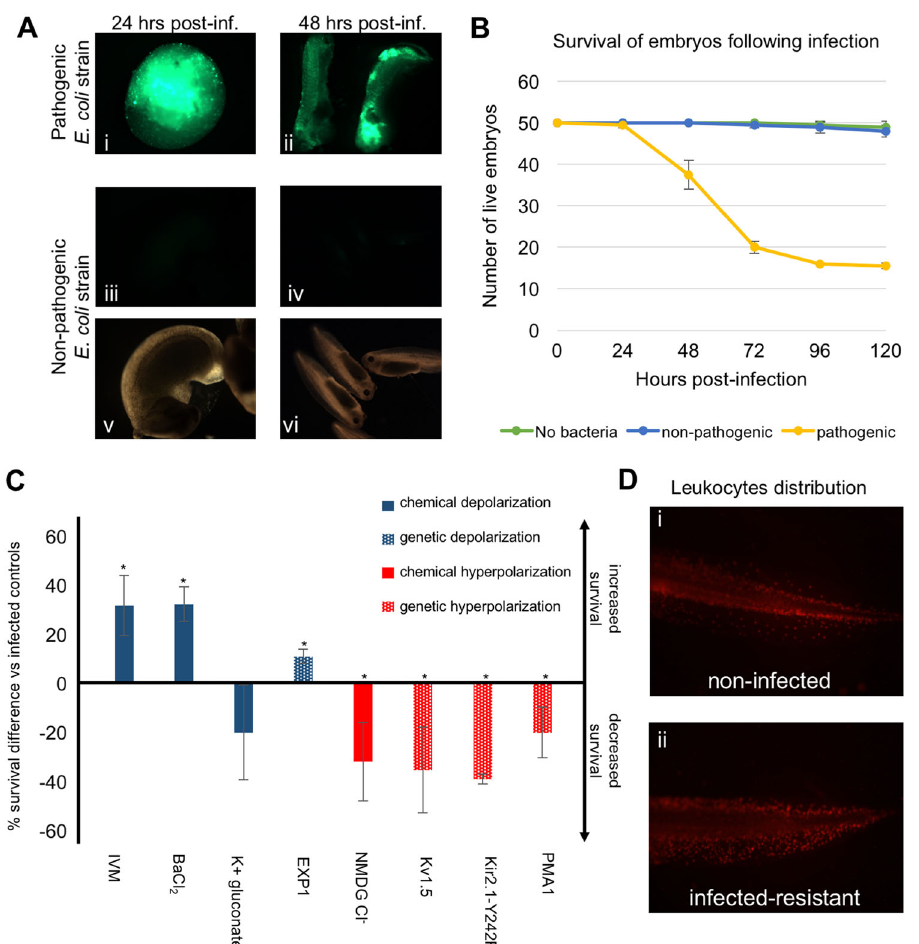
Fig. 1 Uropathogenic E. coli can produce systemic infection of gastrula-stage X. laevis embryos, whose V mem modulates immune response to infection. a Widely distributed uropathogenic E. coli -derived-GFP fl uorescence is detected under fl uorescence microscopy in embryos infected 24 h (panel i) or 48 h (panel ii) before the image was captured. In contrast, the non-pathogenic K12 E. coli lab strain harboring the same GFP reporter fails to colonize the embryos after injection ( fl uorescent imaging in panels i – iv, bright fi eld imaging in panels v – vi). b Comparative survival curves of embryos injected with vehicle solution (no bacteria, green line ), non-pathogenic E. coli ( blue line ), or uropathogenic E. coli ( yellow line ). Error bars represent the standard deviation from three biological replicates. Embryos showing no motion after poking or being in a state of lysis were counted as dead. c Embryo ’ s V mem modulates immune response to infection. General embryo depolarization increases the rate of survival following infection while general embryo hyperpolarization decreases post-infection survival. For chemical polarizations, embryos were kept in normal conditions until after infection (late gastrula stage), at which point the speci fi ed compounds were added to their media. For genetic modi fi cations of polarity, one-cell embryos were injected with mRNAs coding for the speci fi ed transmembrane channels, incubated until they reach the gastrula stage, and infected with uropathogenic E. coli . Surviving embryos were counted 4 days after infection (chemical depolarization conditions in solid blue columns , chemical hyperpolarization condition in solid red column ; genetic depolarization condition in dotted blue column , genetic hyperpolarization conditions in dotted red columns ). Error bars represent the standard deviation from at least three biological replicates. *denotes p < 0.05. IVM ivermectin, NMDG N -methyl- D -glucamine. d Resistant embryos show peripheral mobilization of leukocytes. Fluorescence detection of leukocytes with the speci fi c XL2 antibody in embryos surviving 4 days after infection. Panel i shows a non-infected embryo while panel ii shows an infected